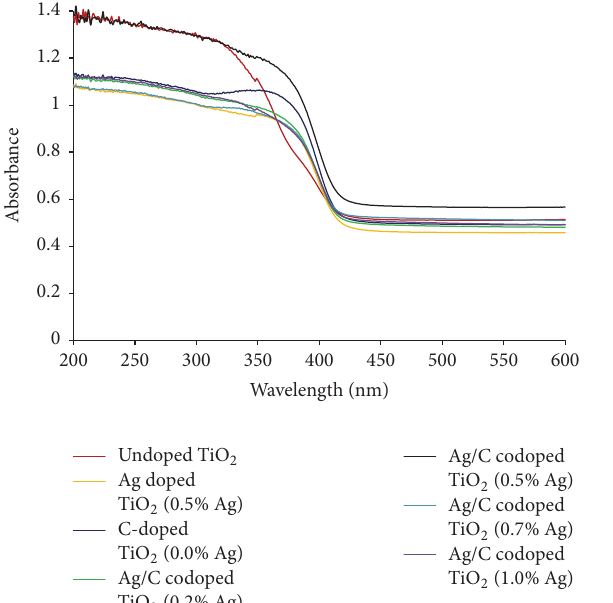
Figure 4: UV-Vis absorption spectra of the undoped TiO 2 , Ag doped TiO 2 , C-doped TiO 2 , and Ag/C codoped TiO 2 photocatalysts with different Ag loadings.